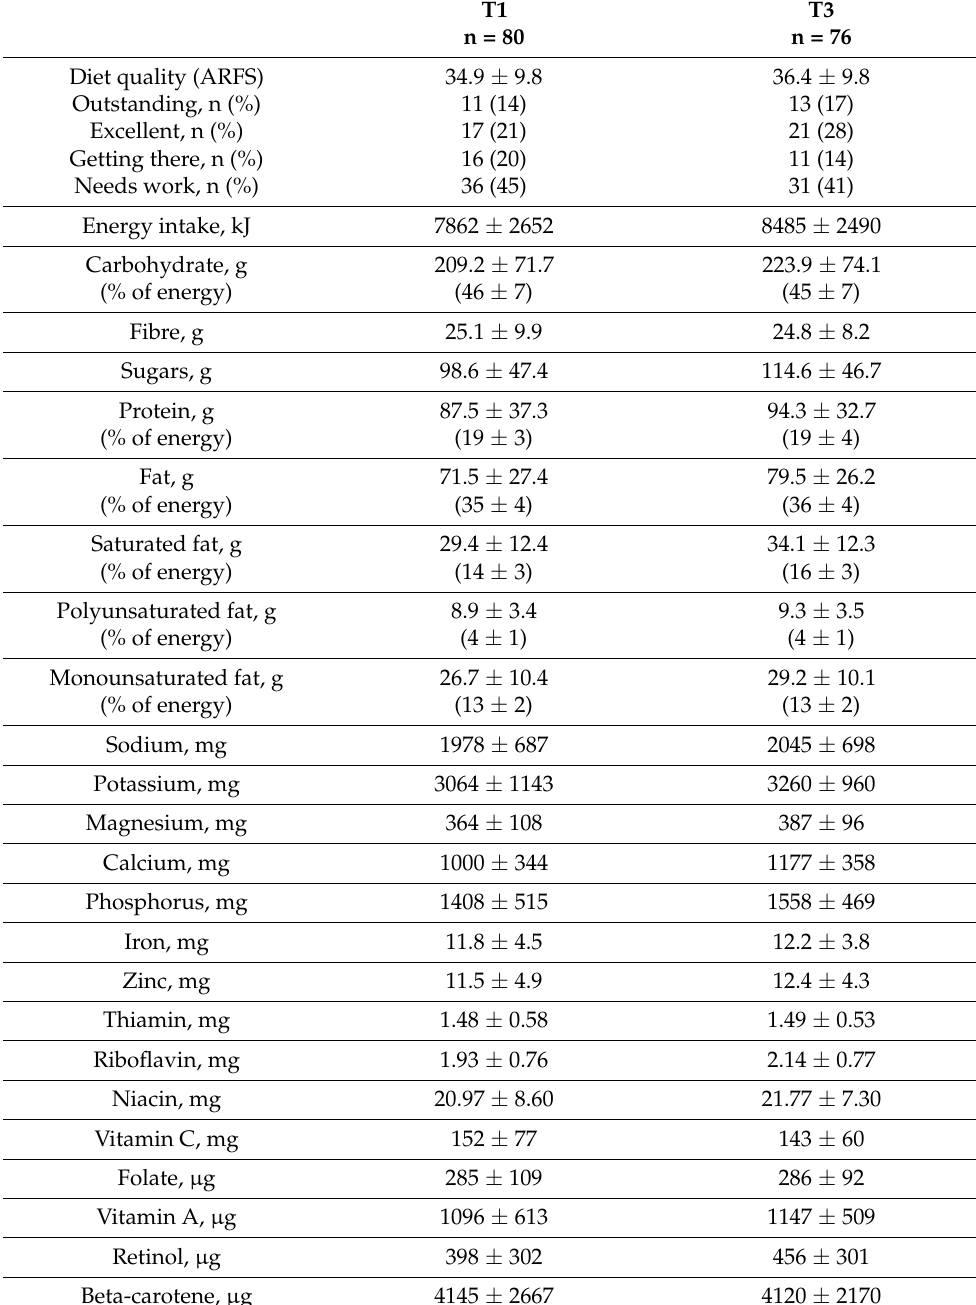
Table 2. Participant daily dietary intake during trimester 1 and trimester 3 of